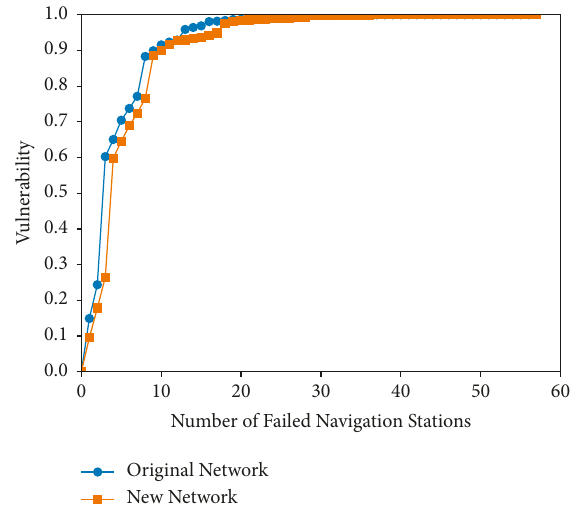
Figure 8: Vulnerability comparison of the original navigation network and the improved network under the malicious attack based on the comprehensive importance of navigation